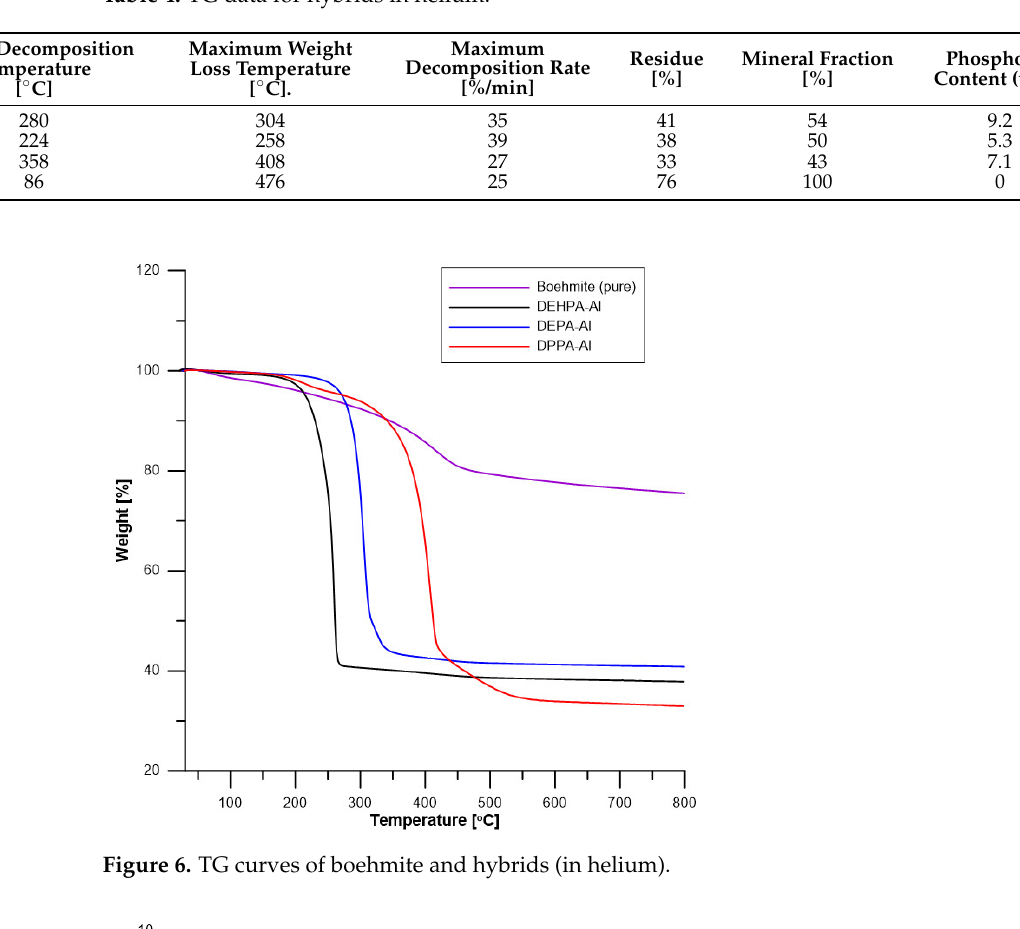
Table 4. TG data for hybrids in helium.